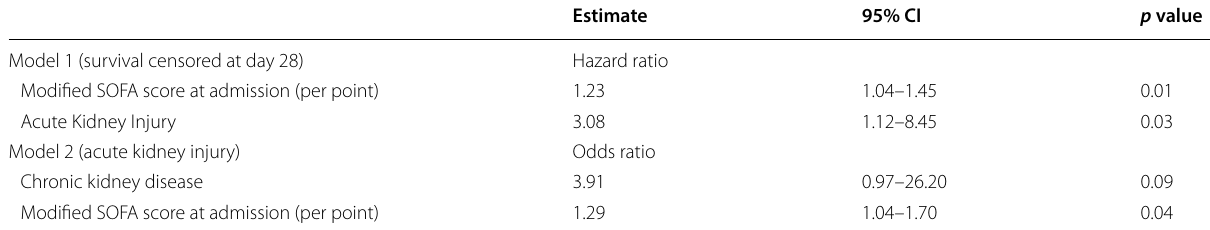
Table 2 Factors associated with survival censored at day 28 (Cox Model) and risk of AKI (logistic regression)